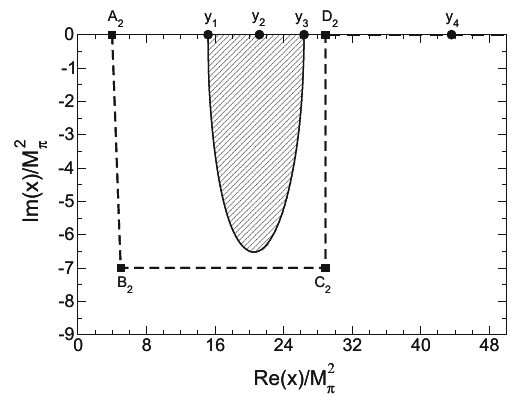
Fig. 10 The case ω → 3 π . Solid line: Same as solid line in Fig 9, with M 2 η replaced by M 2 ω . Dashed: A deformed integration path. Any deformedpaththatdoesnotcrossthesolidlineallowsforanundistorted integration in the angular average (4). For notation see Appendix A. √ D 2 (cid:14) 0 . 75 GeV, i.e., the Schenk parameterization is still Note that operative at D 2 and generates holomorphic phase